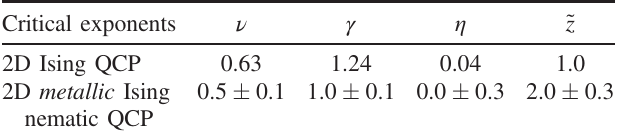
TABLE I. Critical exponents for a 2D Ising QCP with z ¼ 1 (classical 3D Ising), and scaling exponents from DQMC simu- lations near a metallic Ising nematic QCP. In the limit of vanishing coupling to the fermions, exponents from DQMC simulations are consistent with 3D classical Ising values. ~ z is the “ apparent dynamical exponent ” defined below Eq. (1).